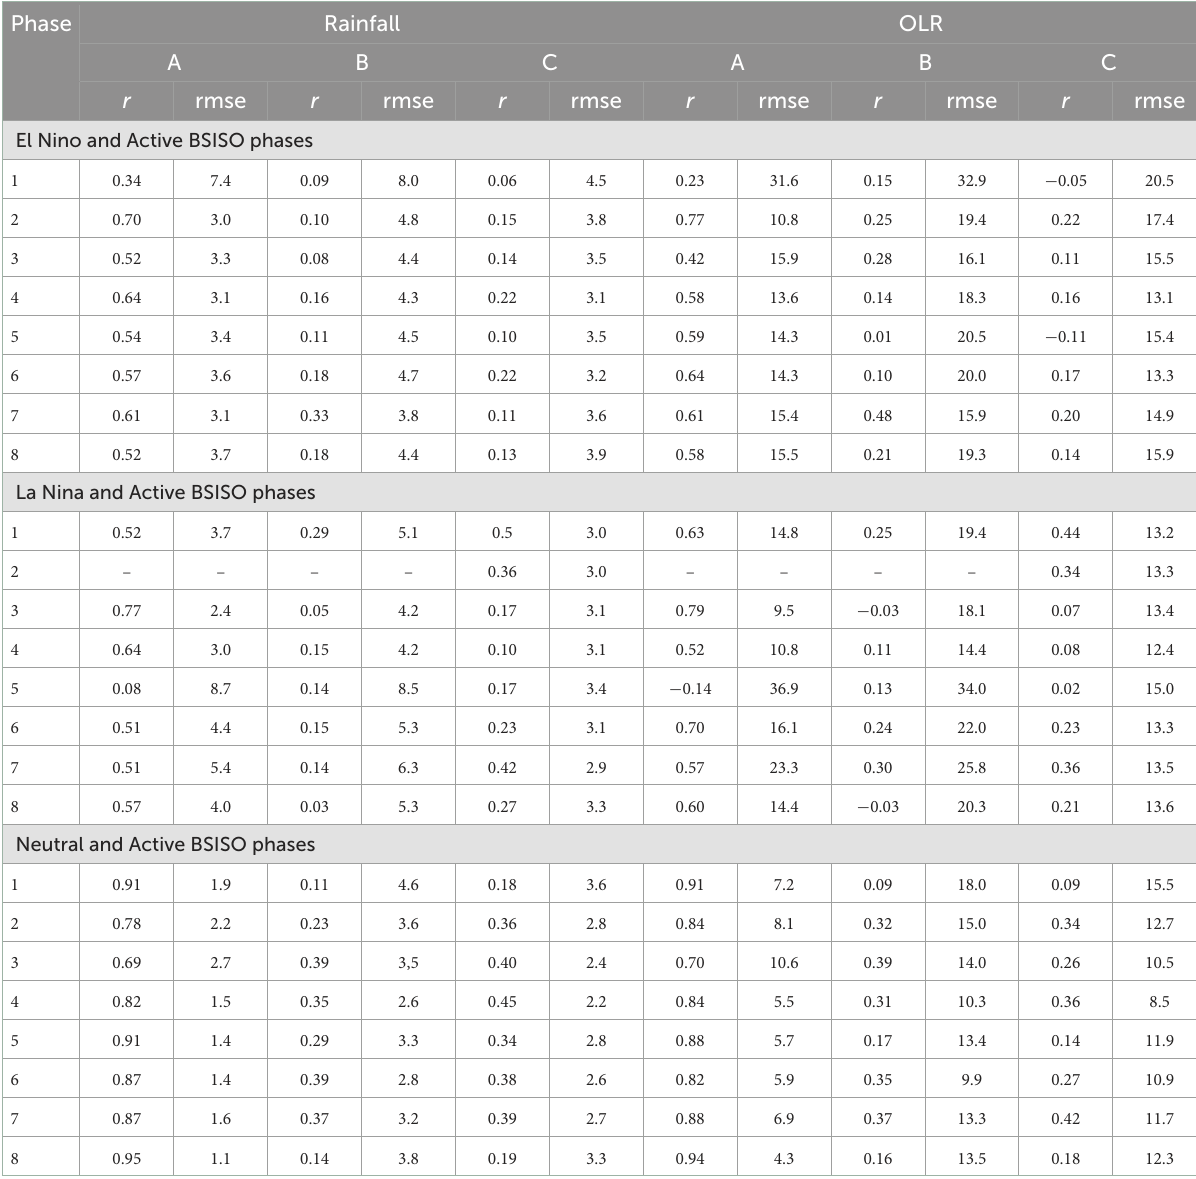
TABLE 4 Pattern correlation and root-mean-square error between observed rainfall anomalies in response to the compound effect of ENSO-BSISO and those of only-BSISO and only-ENSO phases. Phase